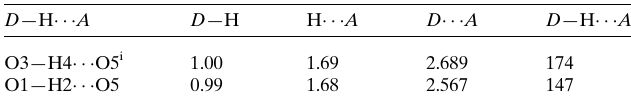
Table 1 Hydrogen-bond geometry (A˚ , (cid:5) ) for